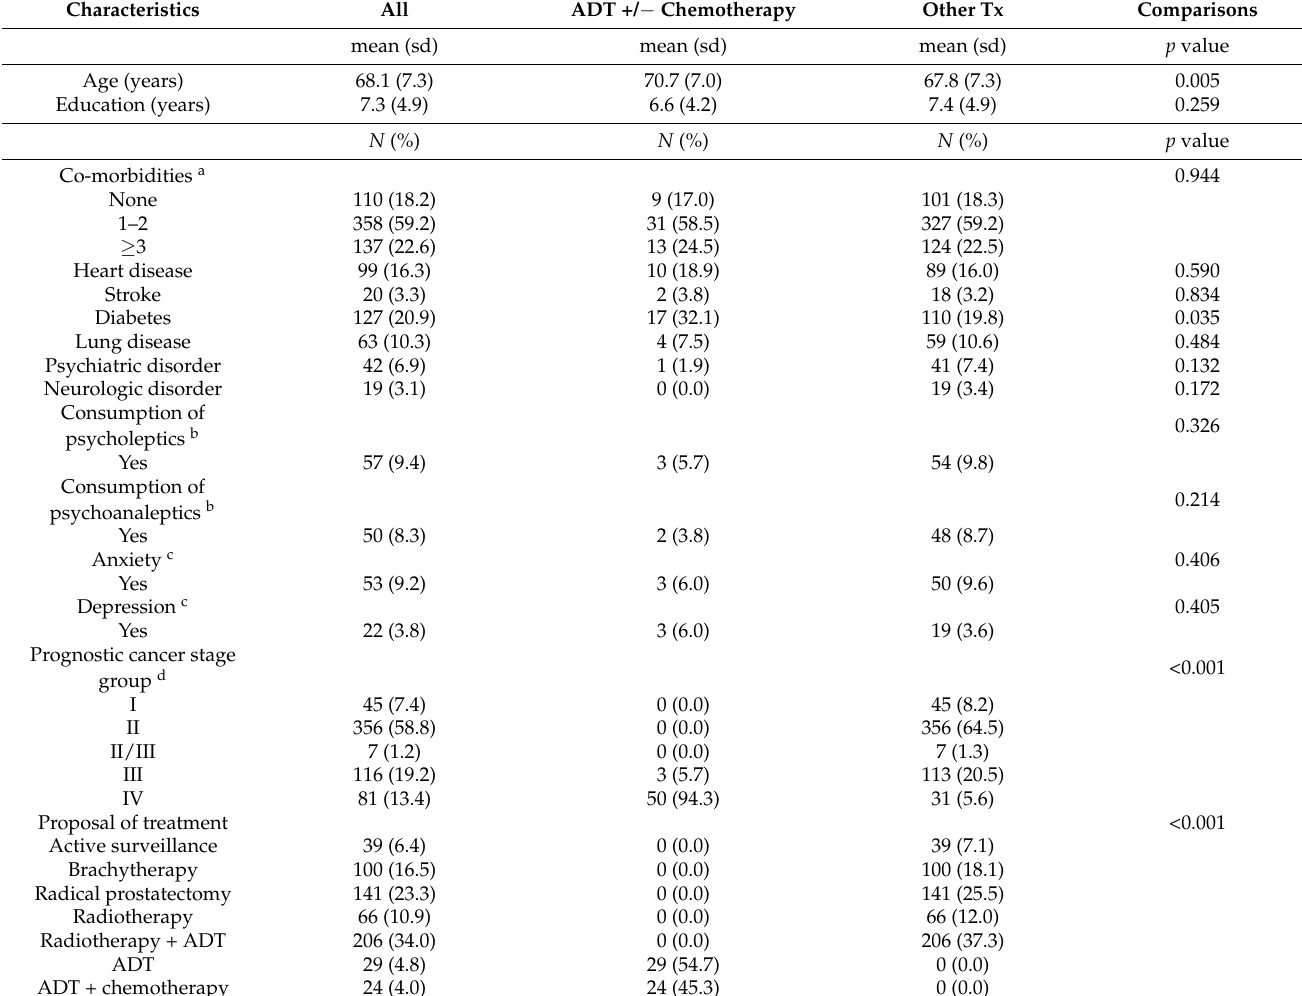
Table 2. Sociodemographic and clinical characteristics of the